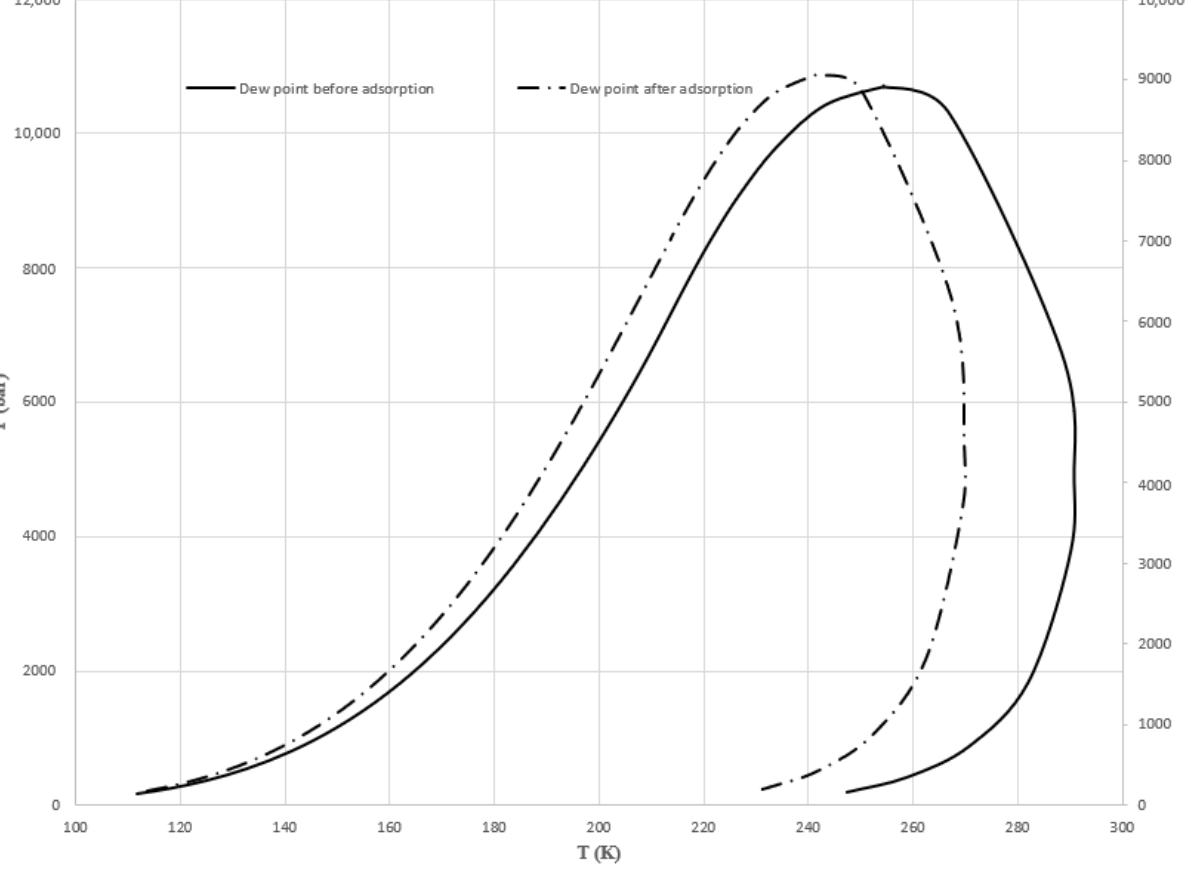
Figure 8. Pressure versus temperature for hydrocarbon dew points before and after desorption.